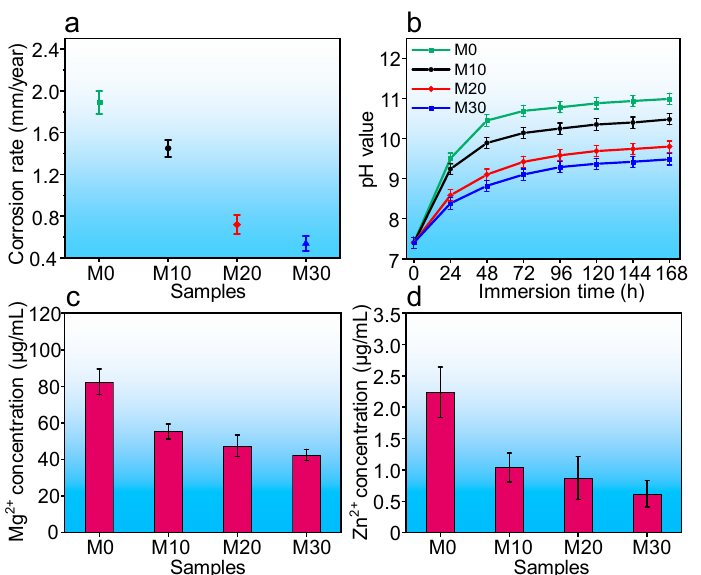
Figure 7. ( a ) Corrosion rates, ( b ) pH values, and ( c ) Mg 2+ and ( d ) Zn 2+ ion concentrations for all sample extracts.